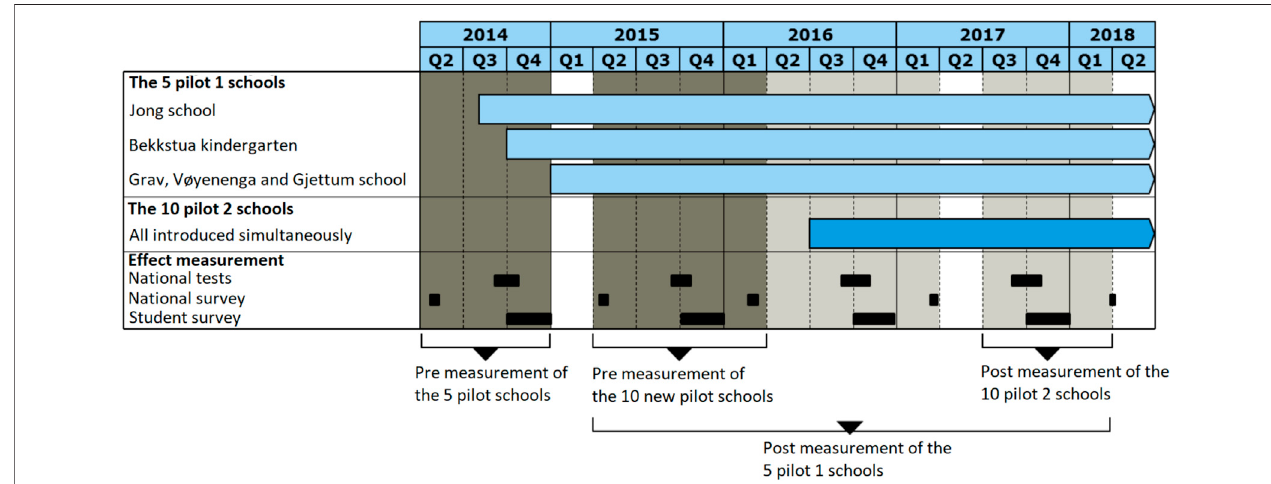
FIGURE 2 | Overview of the introduction of tablets and the three effect